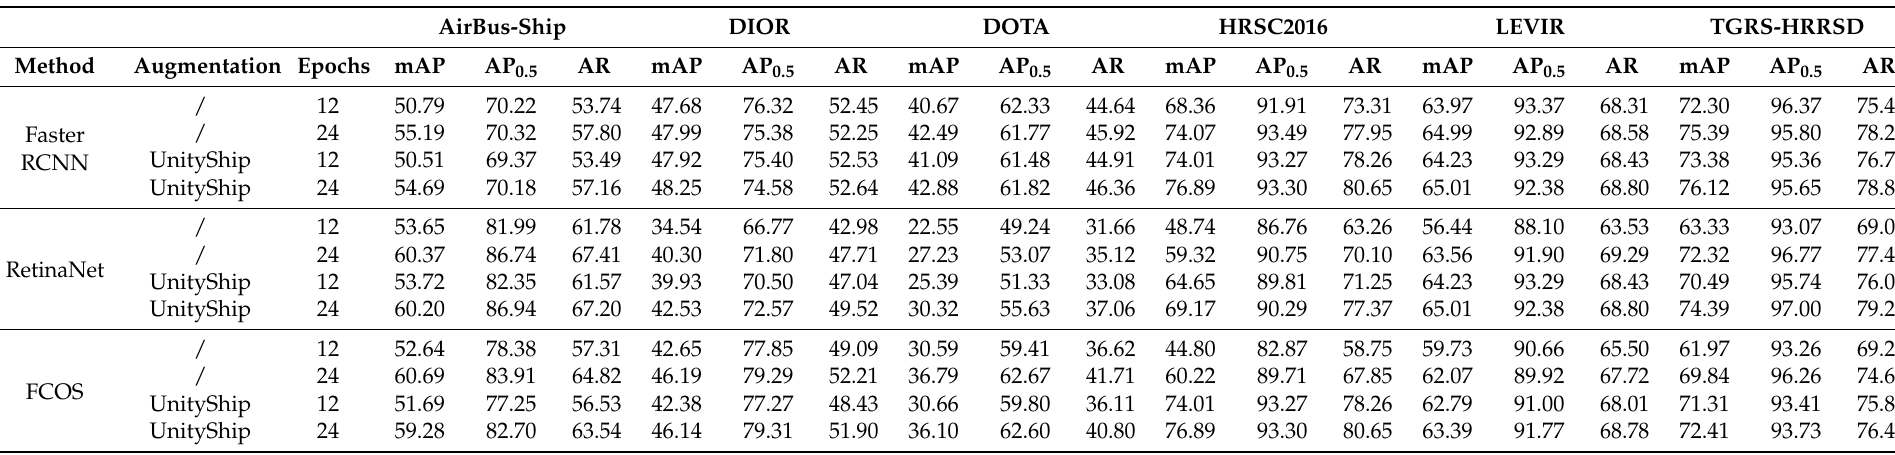
Table 7. Comparison of mAP, AP 0.5 , and AR for different datasets with and without augmentation and different training